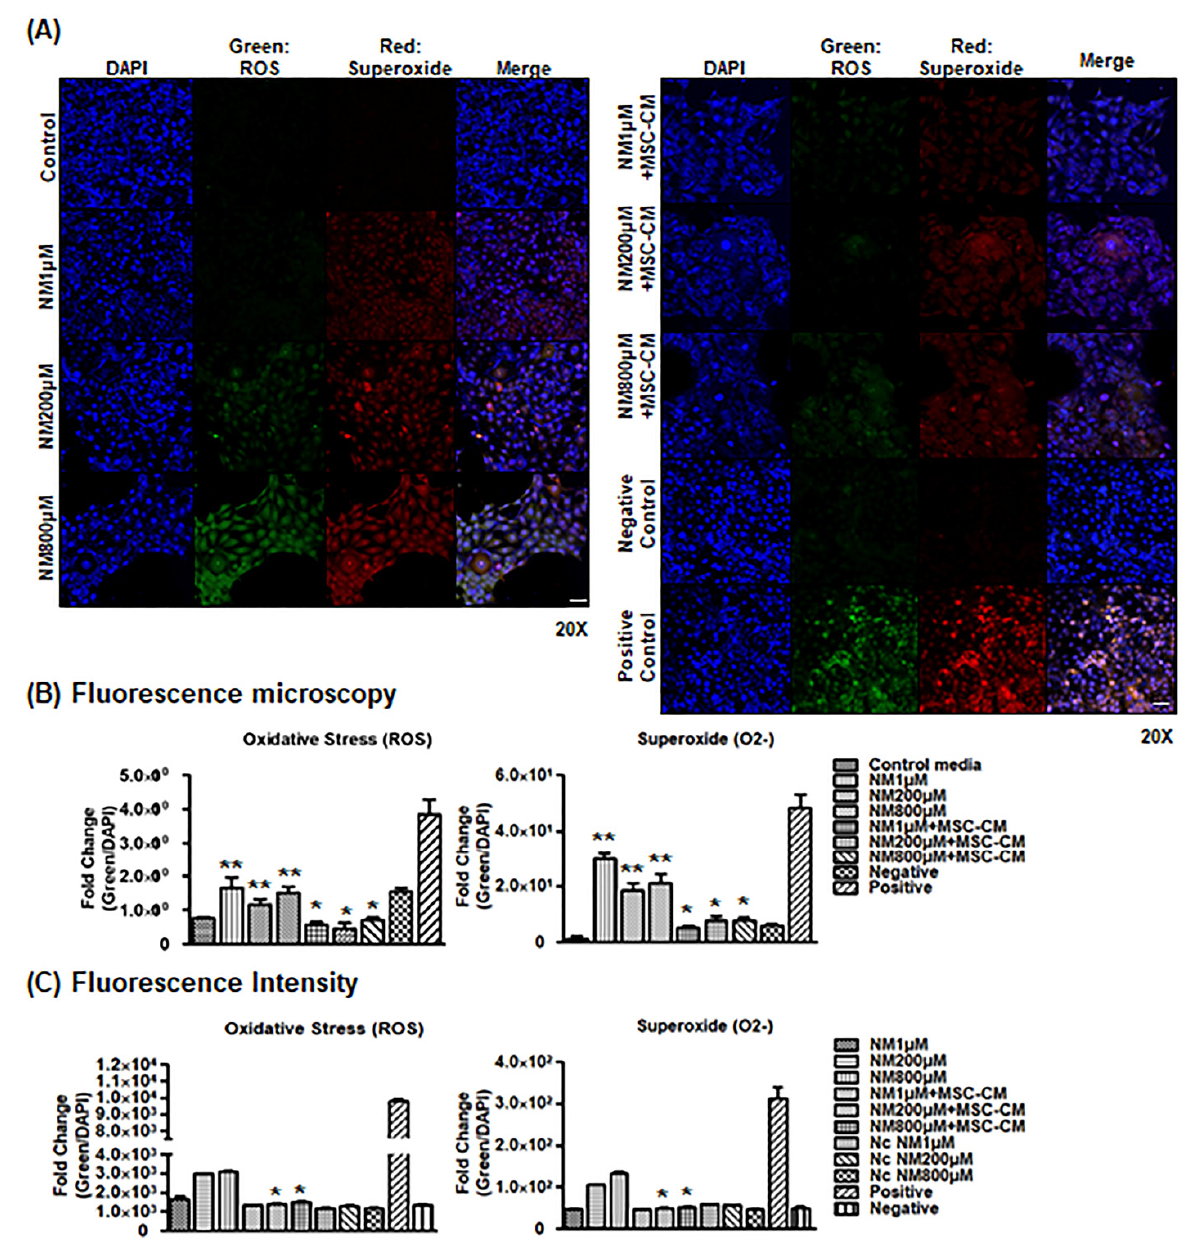
Figure 4. MSC-CM decreases cellular ROS generation. ( A ) Representative confocal immunofluores- cence microscopy images of ROS (green) and Superoxide (red) after various doses of NM with or without MSC-CM. Scale bar, 50 µ m ( B ) Relative fold changes from Figure 4A. ** p < 0.01 vs. Control media, * p < 0.05 vs. NM treated group. ( C ) Representative ROS/Superoxide assay showing the effect of MSC-CM on NM exposure in cell culture. Fluorescence intensity after NM (1, 200, and 800 uM) and NM with MSC-CM incubation for 2 h. Positive control (ROS Inducer: Pyocyanin). Negative Control (ROS Inhibitor: N-acetyl-L-cysteine). Negative Control (solvent). * p < 0.05 vs. NM treated group.